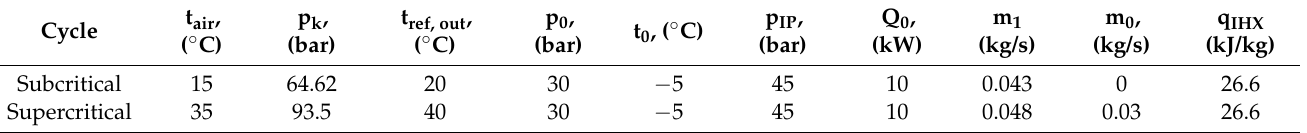
Table 1. Parameters of the R-744 air conditioning system at the beginning of the analysis.